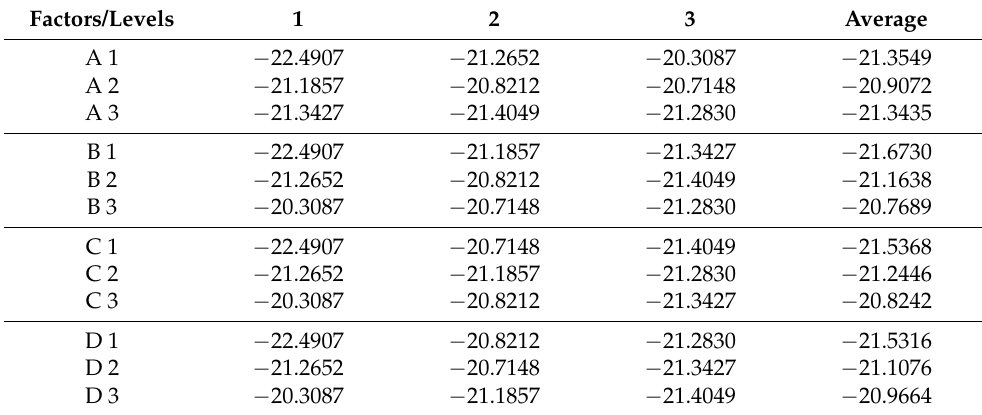
Table 8. Convex S/N Ratio for factors/levels.